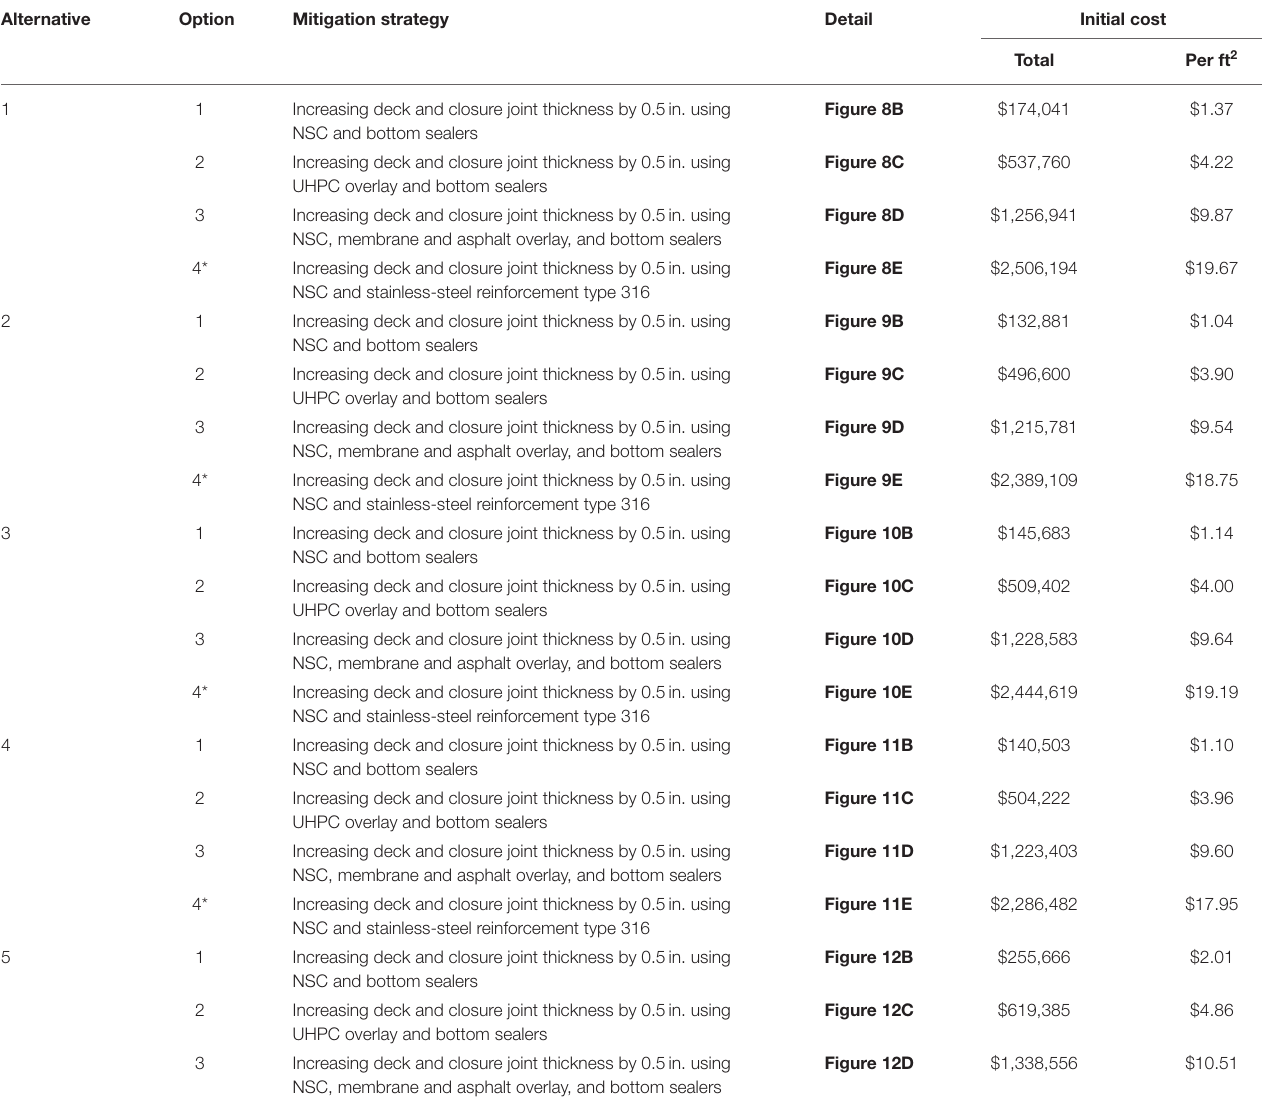
TABLE 4 | Practical implementation example: alternatives, options, mitigation strategies, and initial cost. Alternative Option Detail Initial cost